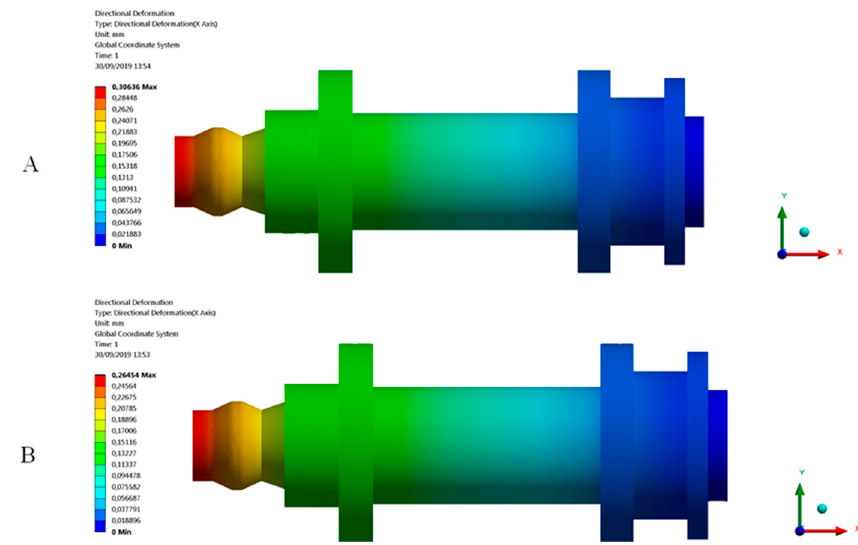
Figure 21. Field of displacements. ( A ) Z-axis printing direction; ( B ) X-axis printing direction.